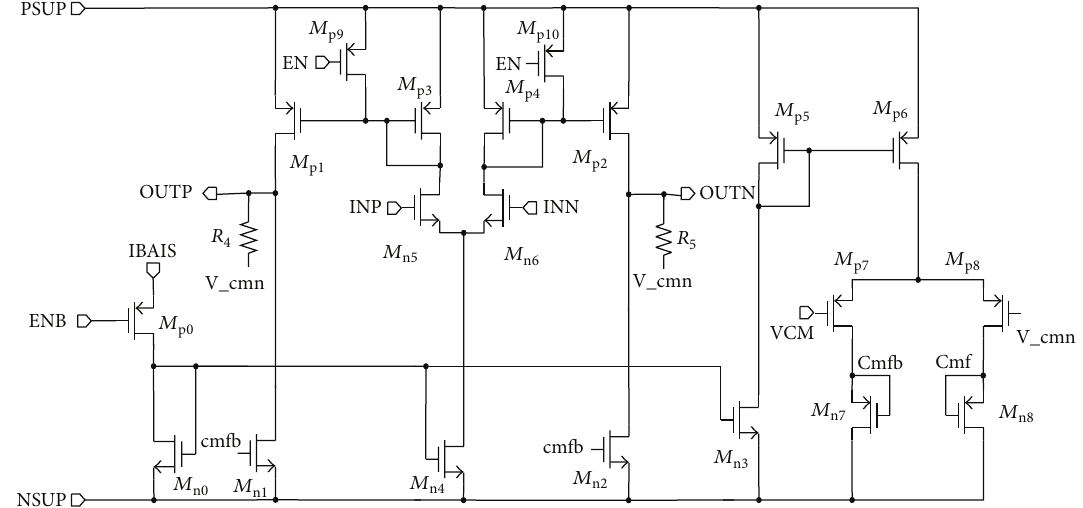
Figure 5: Structure of differential CMOS